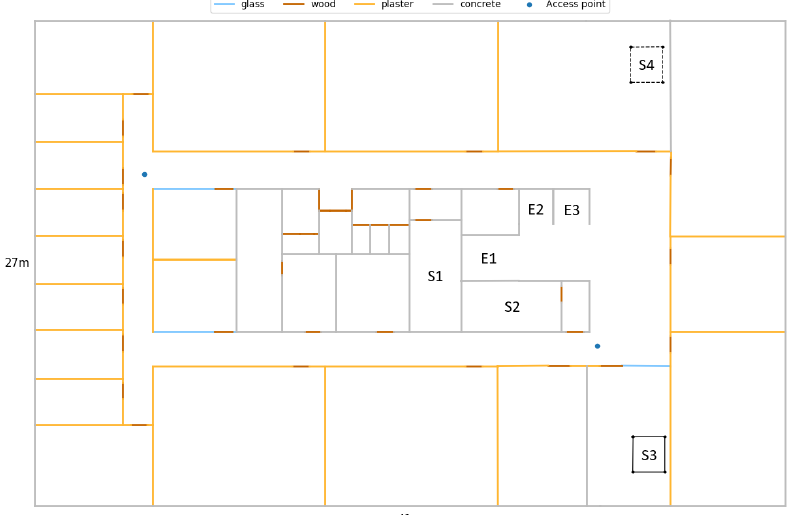
Figure 6. Floor plan of the fifth floor of the office building. E1-3 are elevators. S1–2 are closed concrete staircases that connect to all floors. S3 is an open metal staircase that connects the kitchens of the fifth and sixth floors. An identical staircase connects Floors 7 and 8. S4 is shown in dashed lines because it actually connects Floors 9 and 10. Two access points are located in the corridors. All other floors also have two access points in the corridors.